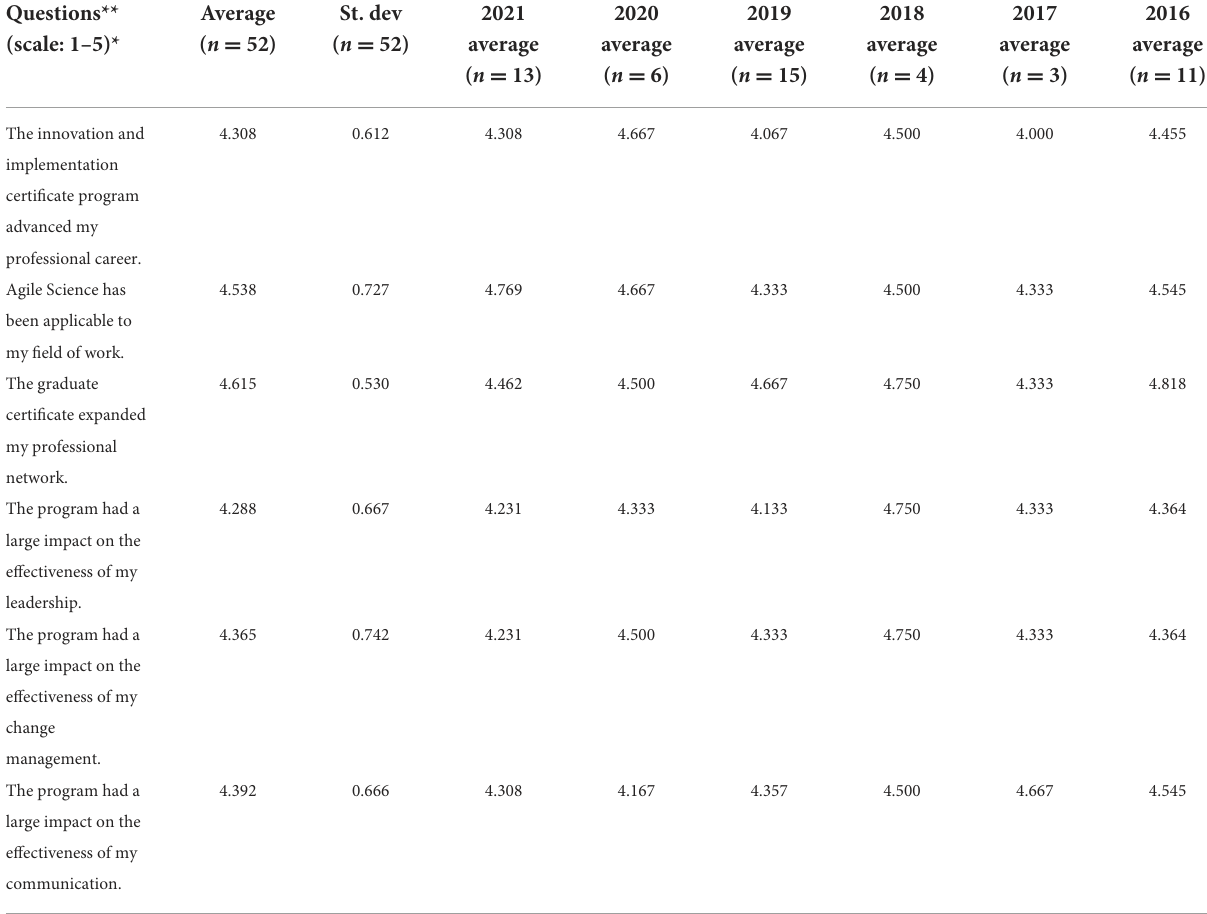
TABLE 1 Survey results of the application of graduate certificate on